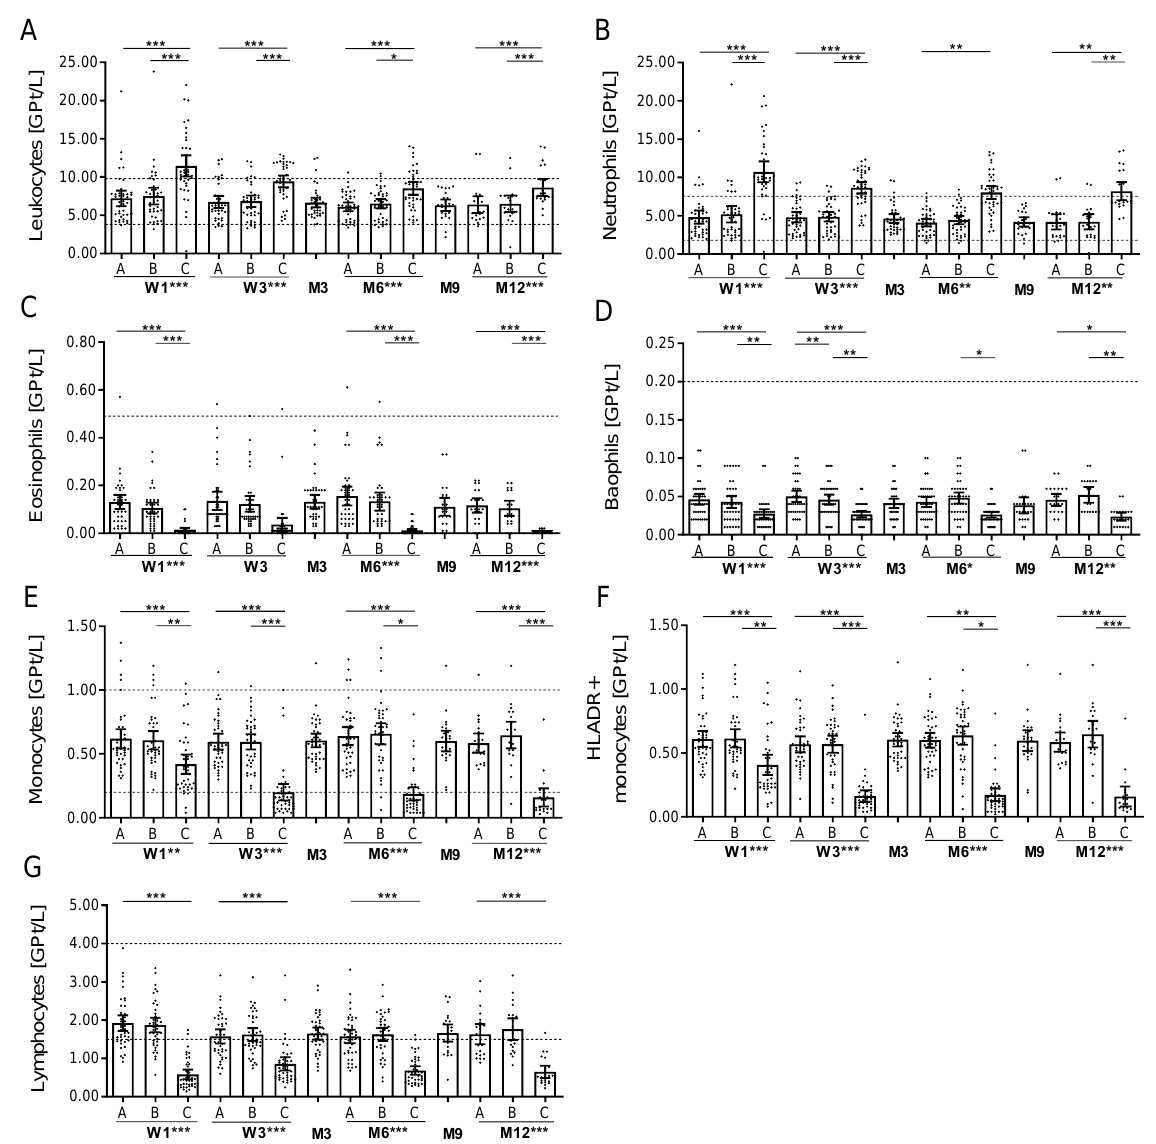
and absolutely decreased after OCR (Figure 2I,J). Directly after the OCR start, CD20+ B cell subsets (B naive and memory cells, plasmablasts, Breg cells) significantly decreased (data not shown) in a prolonged manner. Annexin and viability dye (VD) staining of CD19+ B cells presented dying and dead cells early after the first OCR infusion and even at follow-up visits (Figure 2K,L).